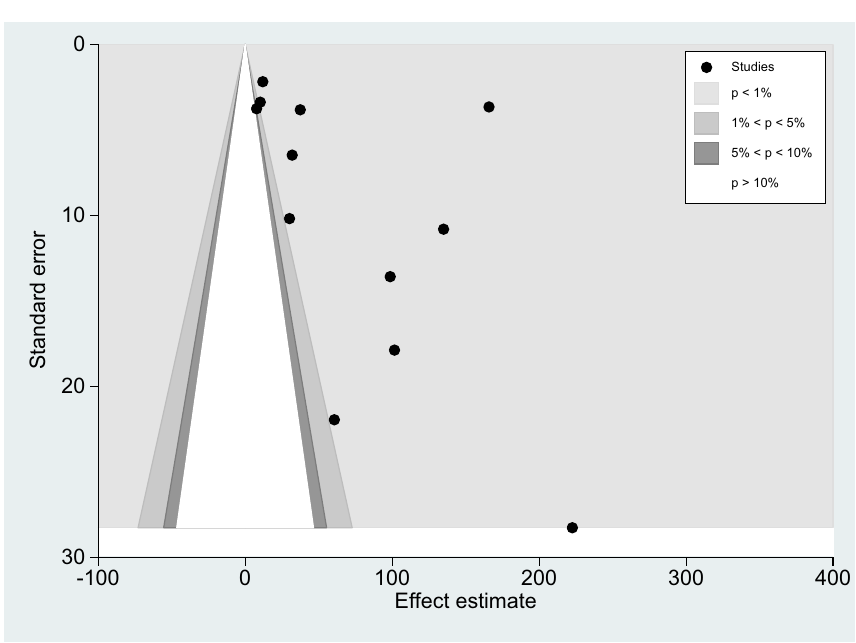
Figure 17. The contour-enhanced funnel plot demonstrated the effect estimates (WMD) were located in a significant area ( P < 1%, 0.01), indicating that the cause of the funnel plot asymmetry was due to publication bias rather than other